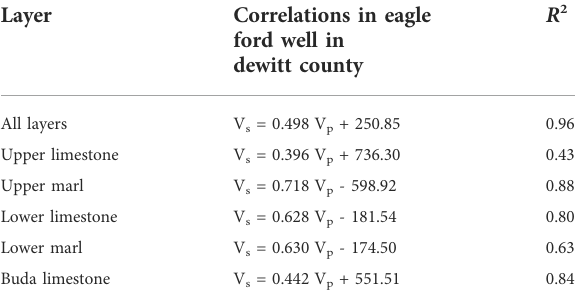
ford well in dewitt county